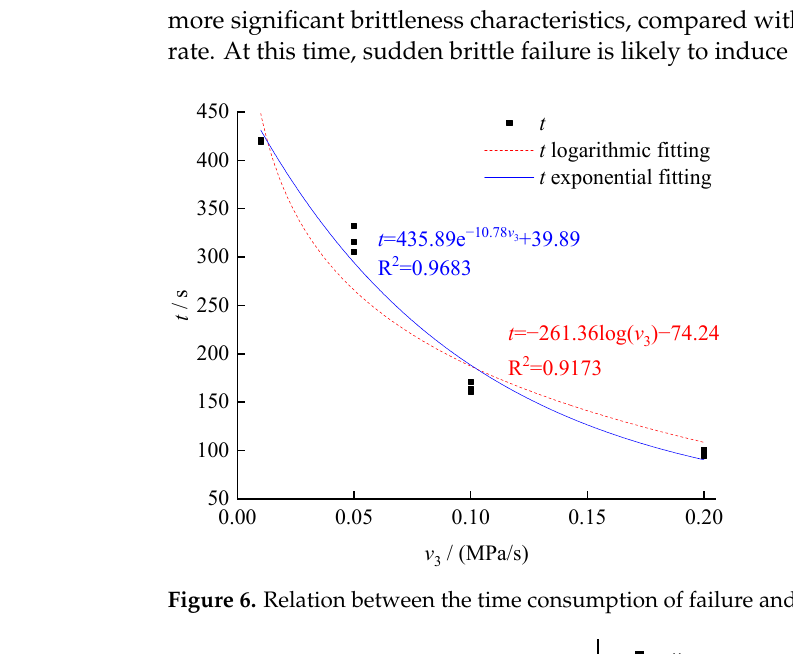
Figure 6. Relation between the time consumption of failure and unloading rate.